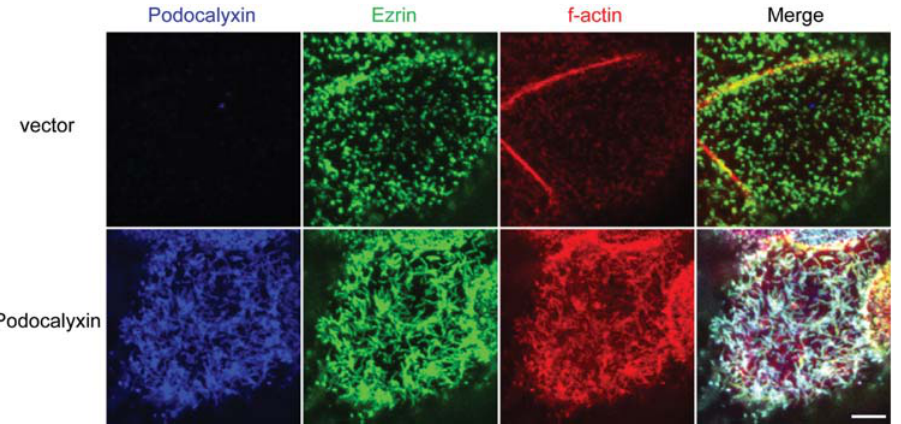
Figure 4. Podocalyxin induces apical recruitment of f-actin and ezrin, and all three molecules colocalize in microvilli. Projections of apical confocal images of MCF-7 cells transfected with murine Podocalyxin or empty vector showing ectopic Podocalyxin (blue), endogenous ezrin (green), and f-actin (red) labeling. White represents colocalization of all three molecules. Note the long extended microvilli in the Podocalyxin-transfected sample. Scale bars: 5 m m.